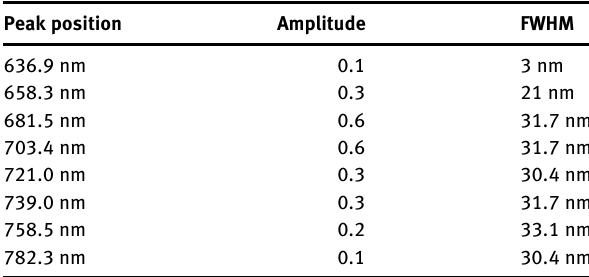
FWHM, full width at half maximum.